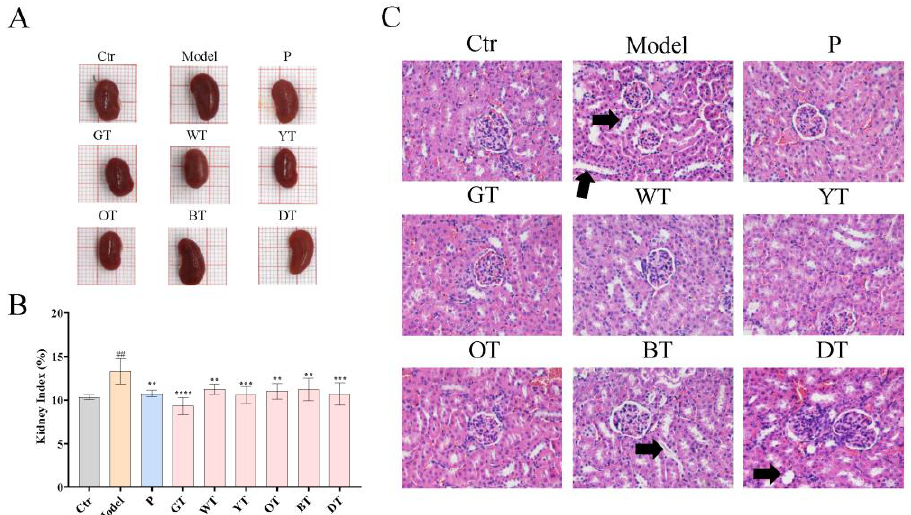
Figure 3. Six types of tea protected against kidney tissue damage in HUA mice. ( A ) Representative images of kidneys in each group. ( B ) Kidney index relative to body weight in the indicated groups. ( C ) Representative H&E-stained renal tissue images of different treatment groups, arrows indicated tubular dilation (200 × ). The data are expressed as mean ± SD. ## p < 0.01 was compared with the control, ** p < 0.01, *** p < 0.001, **** p < 0.0001 were compared with the model.